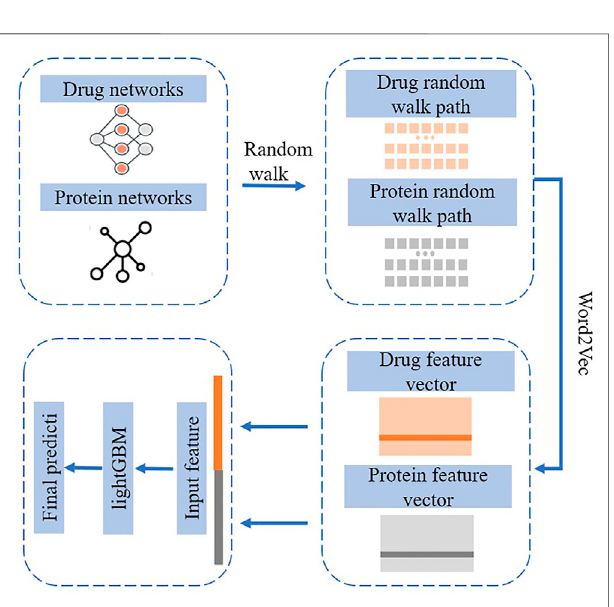
Frontiers in Pharmacology |